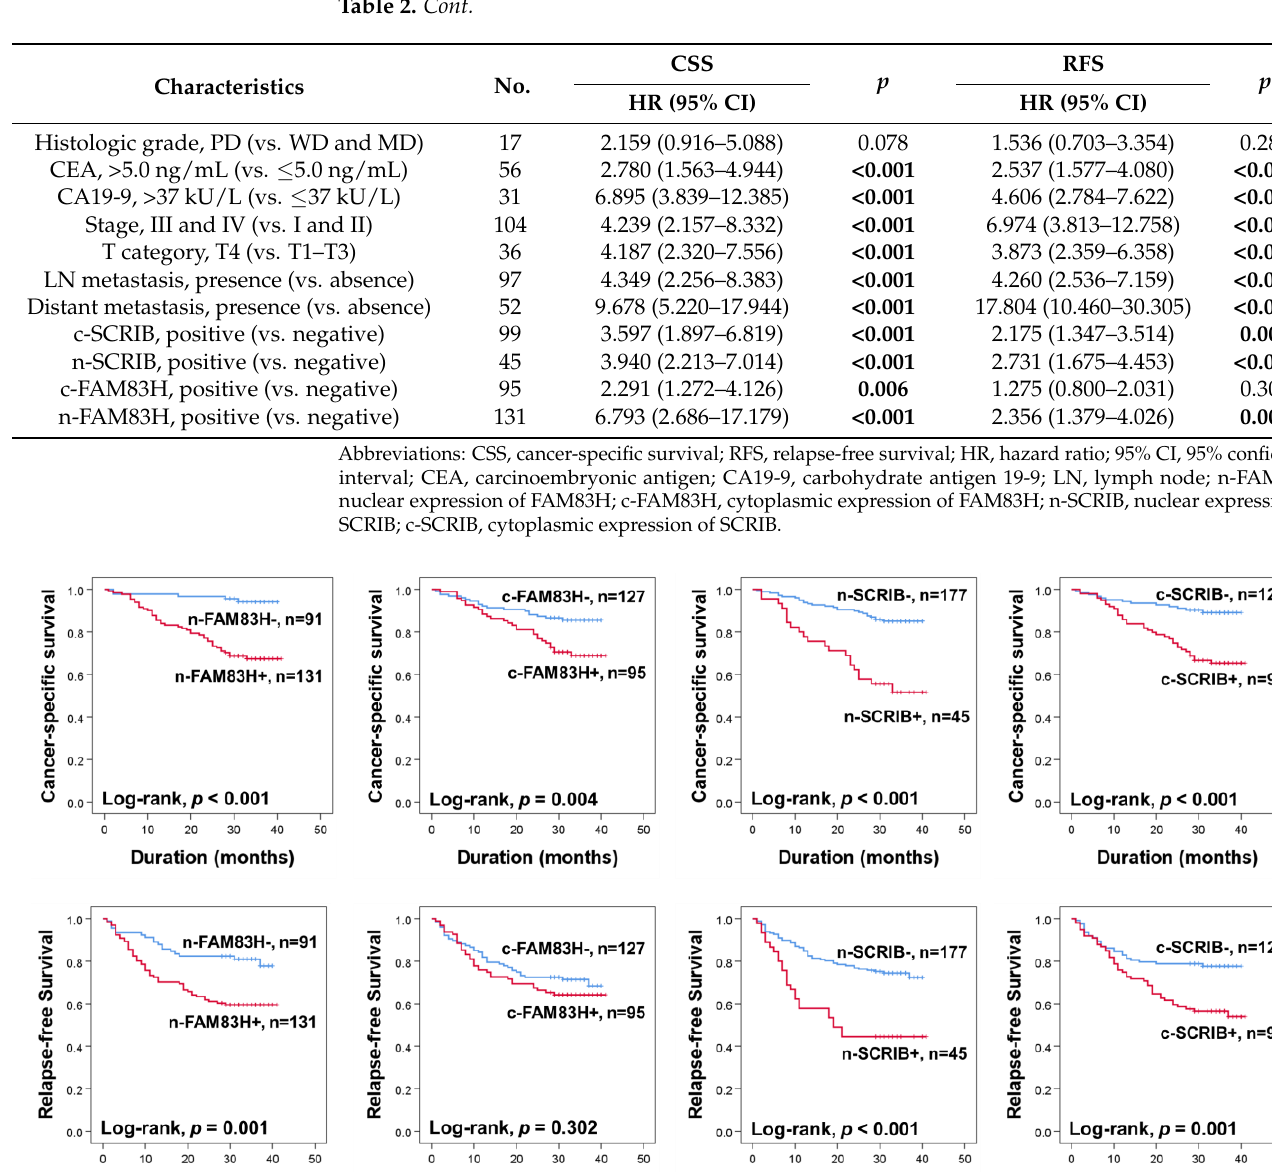
Table 2. Univariate Cox proportional hazards regression analysis for cancer-specific survival and relapse-free survival in 122 CRCs.